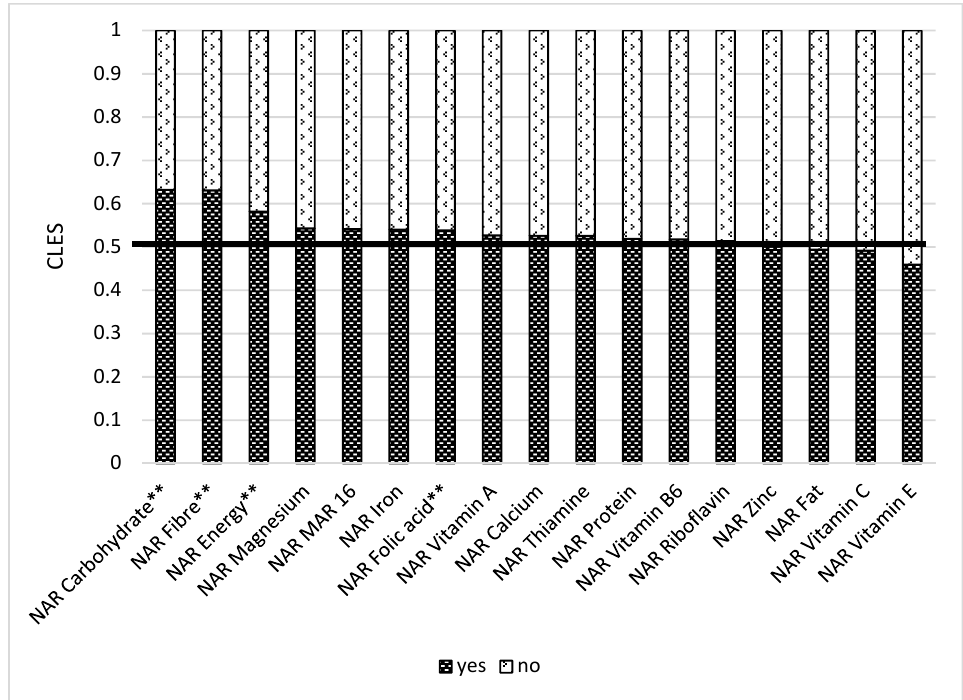
Figure 11. Comparison of NAR 16 nutrients with having at least one farm animal or not . NAR—nutrient adequacy ratio; Mar-16—mean nutrient adequacy ratio for 16 nutrients. CLES—common language effect size; Wilcoxon p -value; ** adjusted p -value < 0.05.